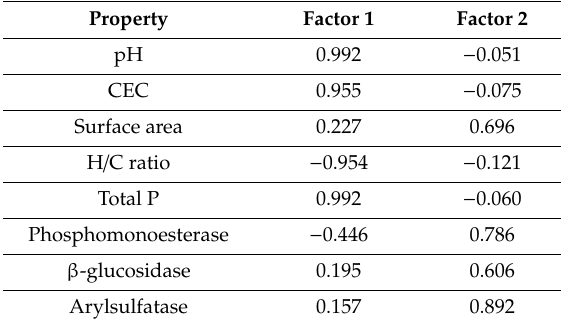
Table 2. Factor analysis of enzyme activities in the treatments with